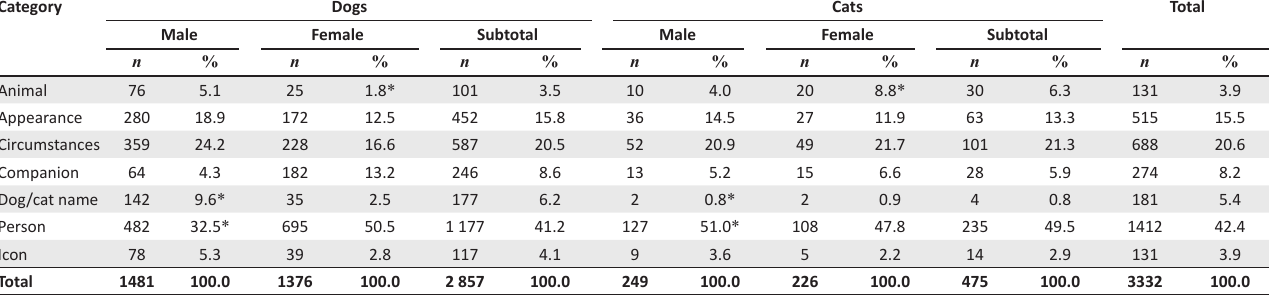
TABLE 5: Proportions of naming categories according to species and sex of pets. Category